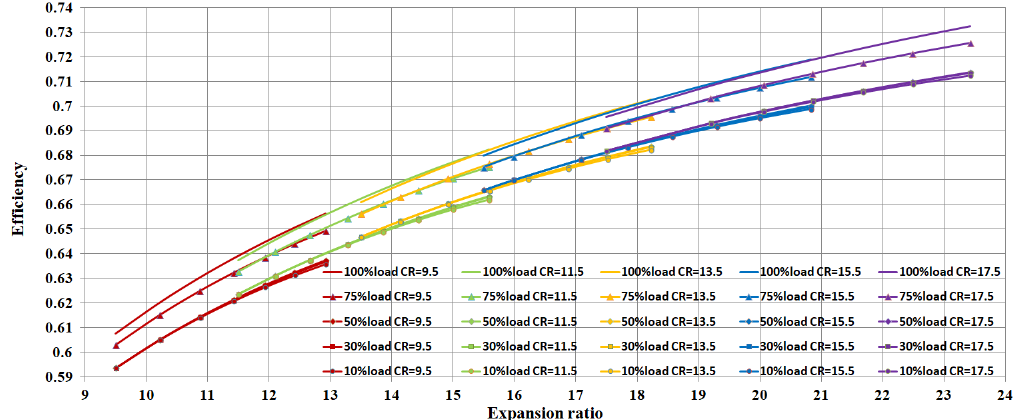
Figure 8. Theoretical efficiency of the DSC-VCR with different engine loads, CRs, and ERs.